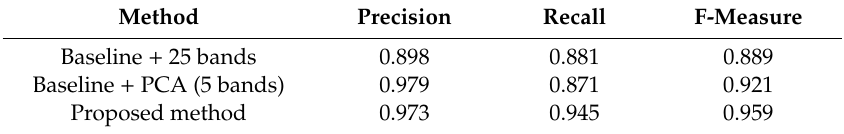
Table 3. Comparative results between the proposed method and PCA in the test